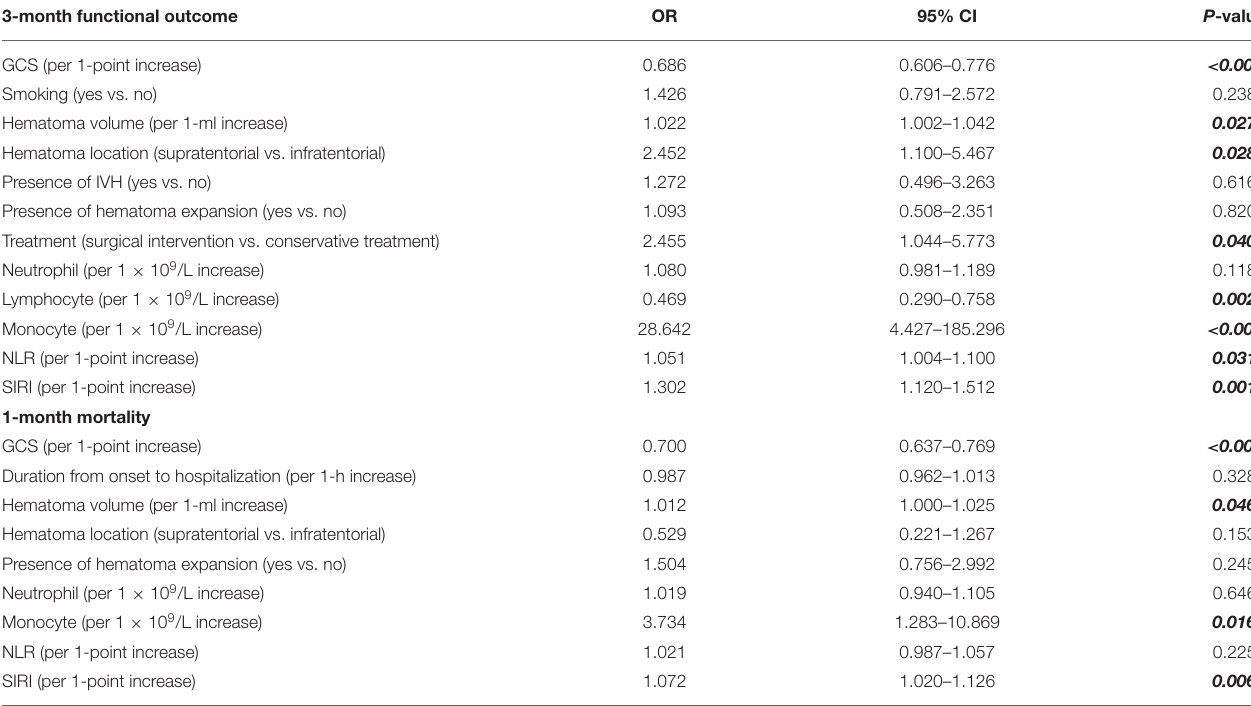
TABLE 3 | Multivariate logistic regression of included clinical variables for 3-month functional outcome and 1-month mortality in original